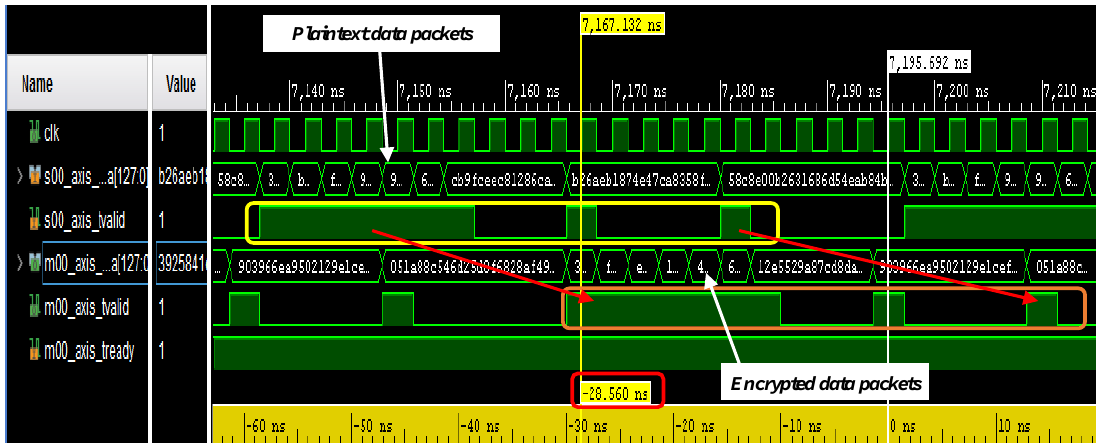
Figure 15. Temporal trends of the signals involved in the encryption algorithm, with the plaintext data packets encrypted on each rising edge of the clock, as indicated by the s00_axis_tvalid signal set to one and the last two packets made available using two impulses spaced randomly over time (yellow box); each encrypted data packet is available at the output after 28.560 ns (10 system clock periods at 350 MHz frequency), as indicated by the m00_axis_tvalid signal (orange box).